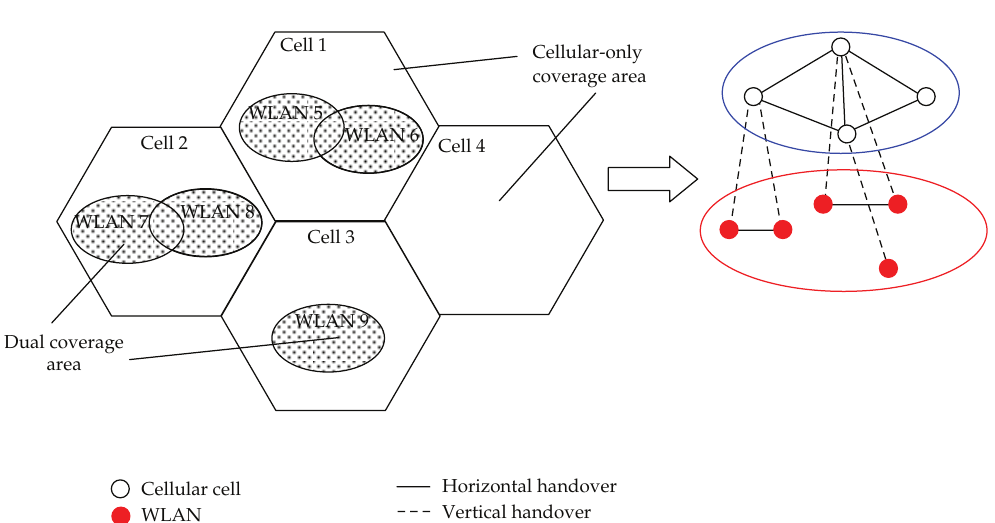
Figure 1: A HetNet (cid:3) cellular/WLAN (cid:4) deployment and its converted network topological representation. (cid:8) of link j is (cid:3) 1 − B j (cid:4) ρ j and a j,r ν r (cid:3) 1 − L r (cid:4) is the sum of the contributions made by each r ∈ R